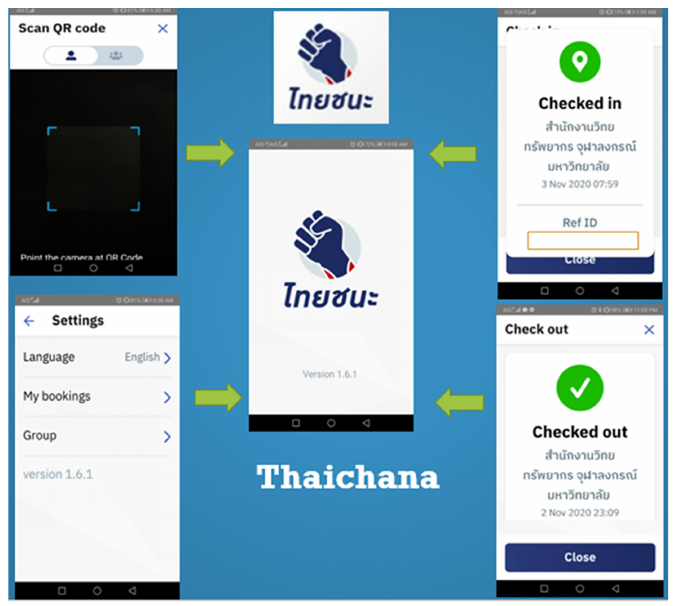
Figure 3. A screenshot of Thai Chana application and its functions on